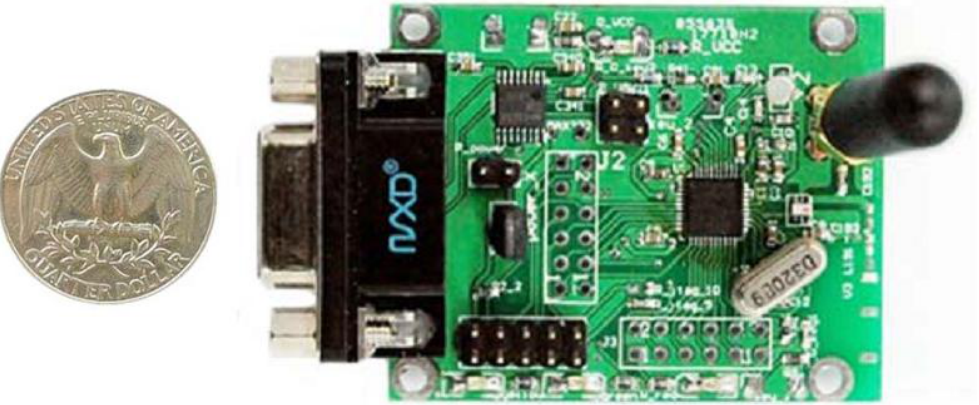
Figure 7. The node used in